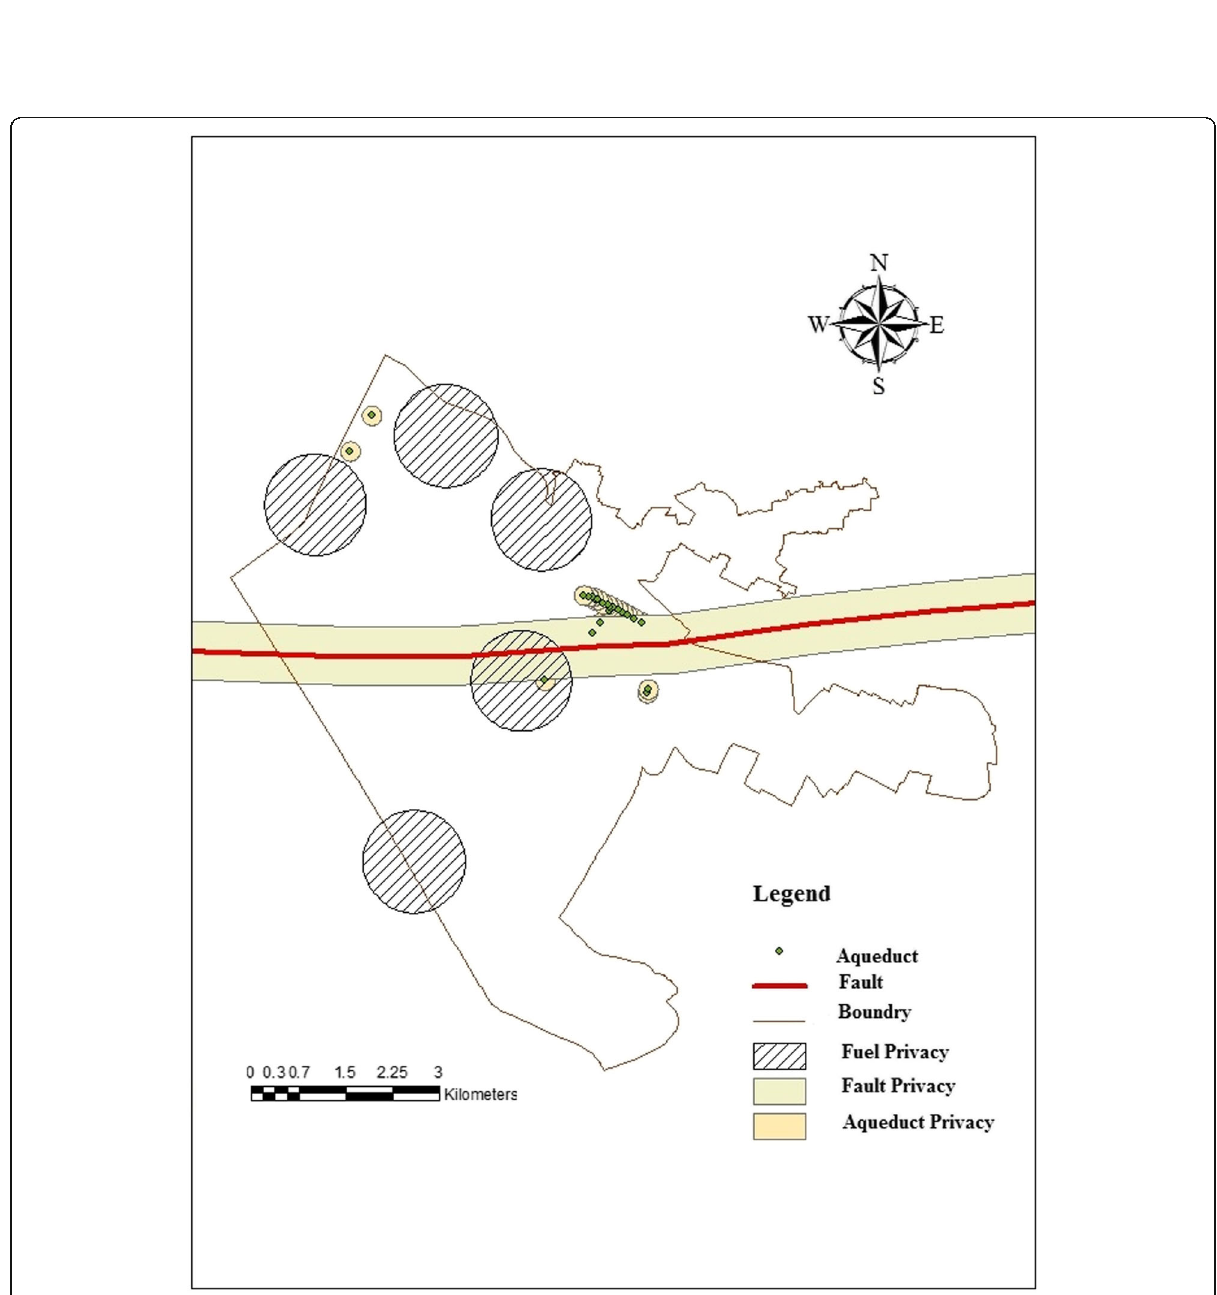
Fig. 10 Areas and their boundaries which are not suitable for